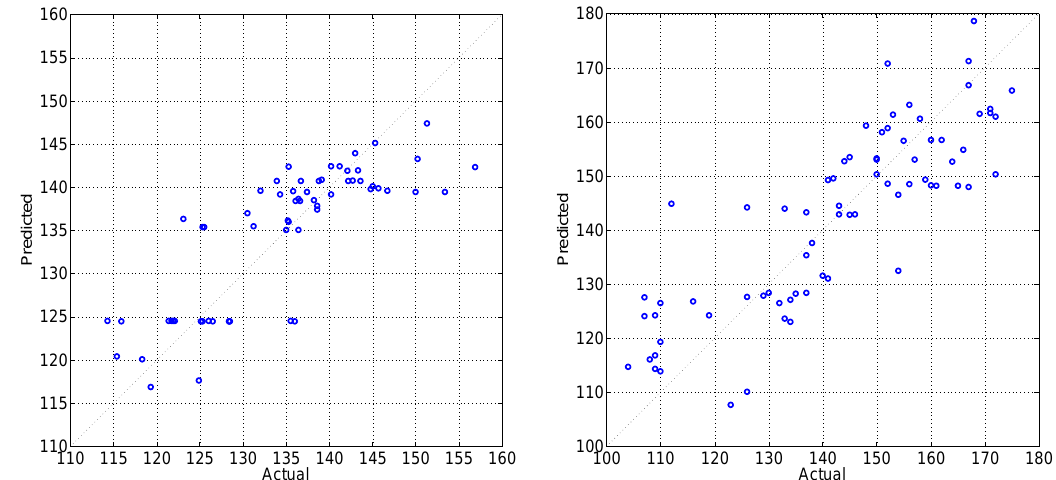
Figure 10. Decision-level fusion for regression task: results for club head speed ( Left ) and ball carry distance ( Right ) prediction. Note: the diagonal dotted line corresponds to an ideal